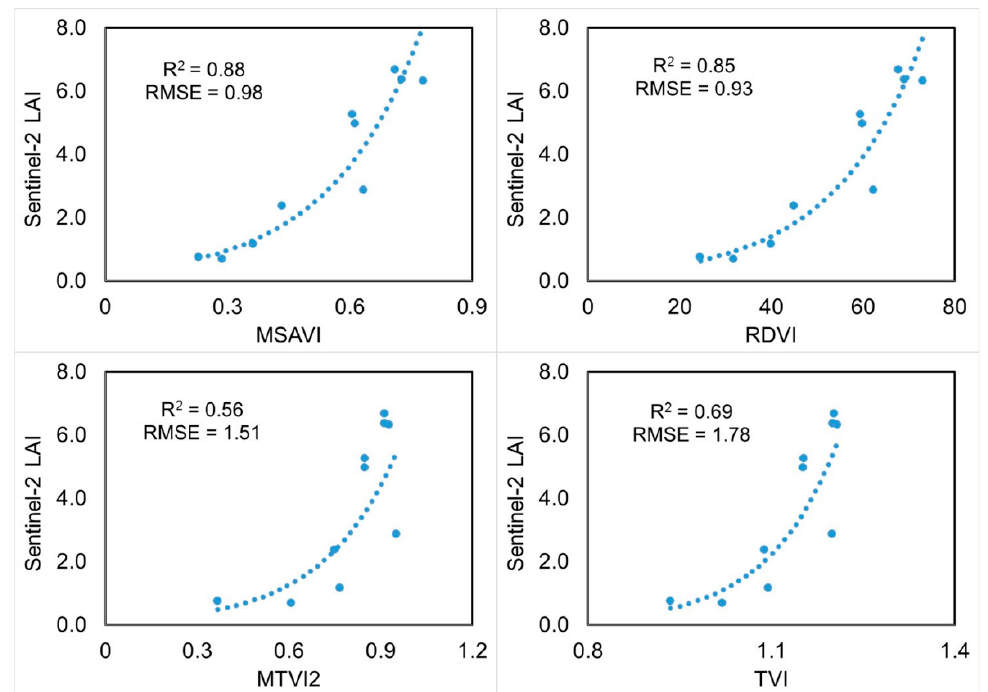
Figure 6. The relationship between S2-LAI (biophysical processor) and vegetation indices derived from Sentinel-2 images for the wheat field from December 2017 to May 2018.